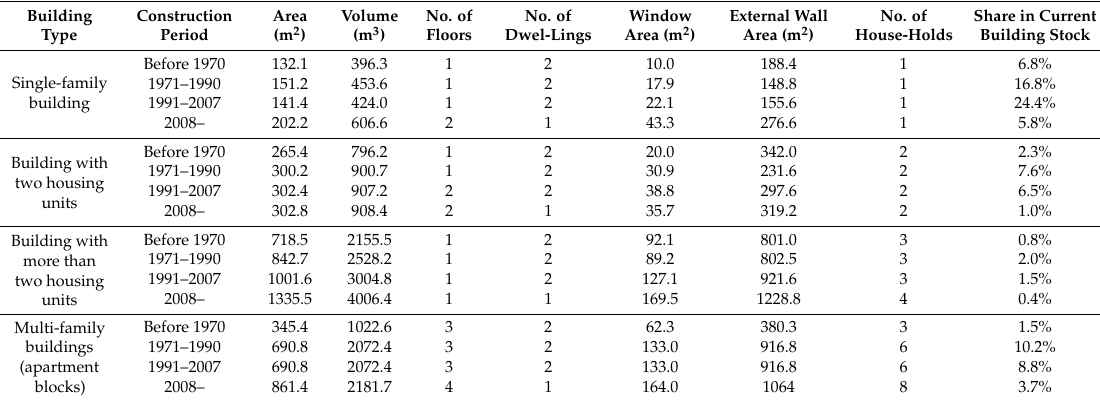
Table 1. Main features of the building typologies used in the model.